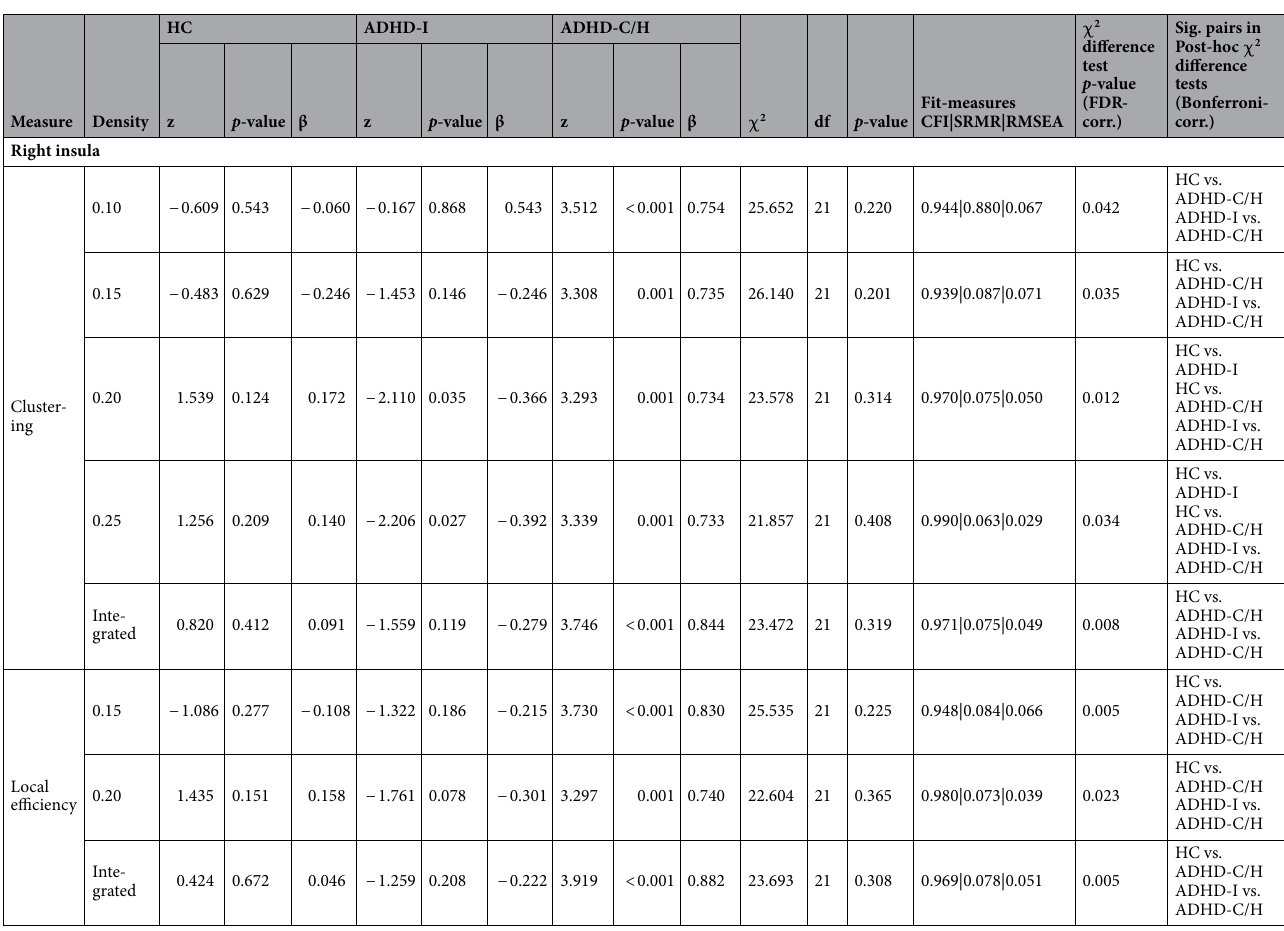
significant differences were found for the left insula and the right ventromedial prefrontal corex and frontal pole. The significant frontal pole difference also showed for the density-integrated values and after applying FDR-controlling procedures (clustering coefficient: p = 0.047, FDR-corrected; see Supplementary Table S1). The significant right insula result, however, was not revealed using threshold-integrated values but only with a den- sity threshold of 25% connectivity and not after FDR-controlling procedures (clustering coefficient: p = 0.033, uncorrected; local efficiency: p = 0.030, uncorrected).